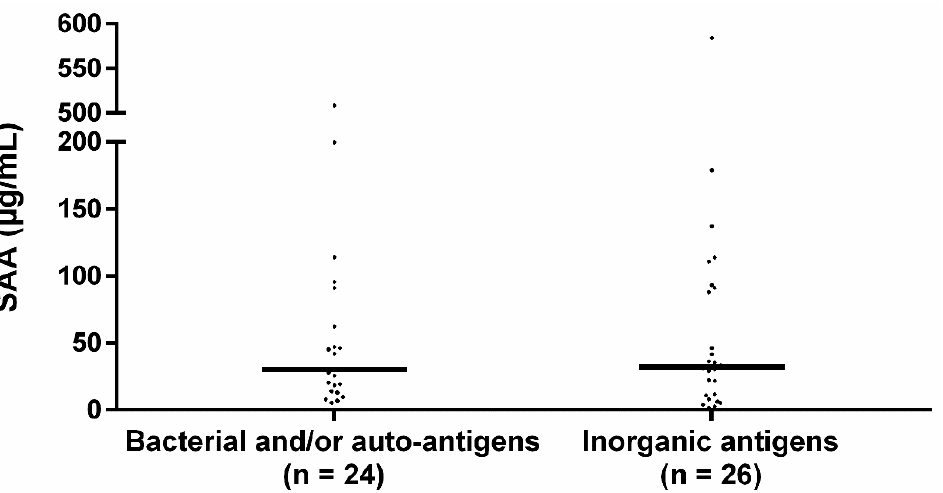
Figure 2. Serum SAA levels in sensitized sarcoidosis sub-groups. Median SAA levels between bacterial sensitized and/or autoantigen sensitized and inorganic agent sensitized sarcoidosis patients did not significantly differ. The percentage of patients using immunosuppressive medication did not significantly differ between the bacterial and/or autoantigen and inorganic sensitized group (33.3% vs. 46.2% respectively, p = 0.355) nor did the percentage of patients using prednisone (20.8% vs. 42.3%, p = 0.104). Bacterial: sensitization to mycobacterial antigens or C. acnes catalase,